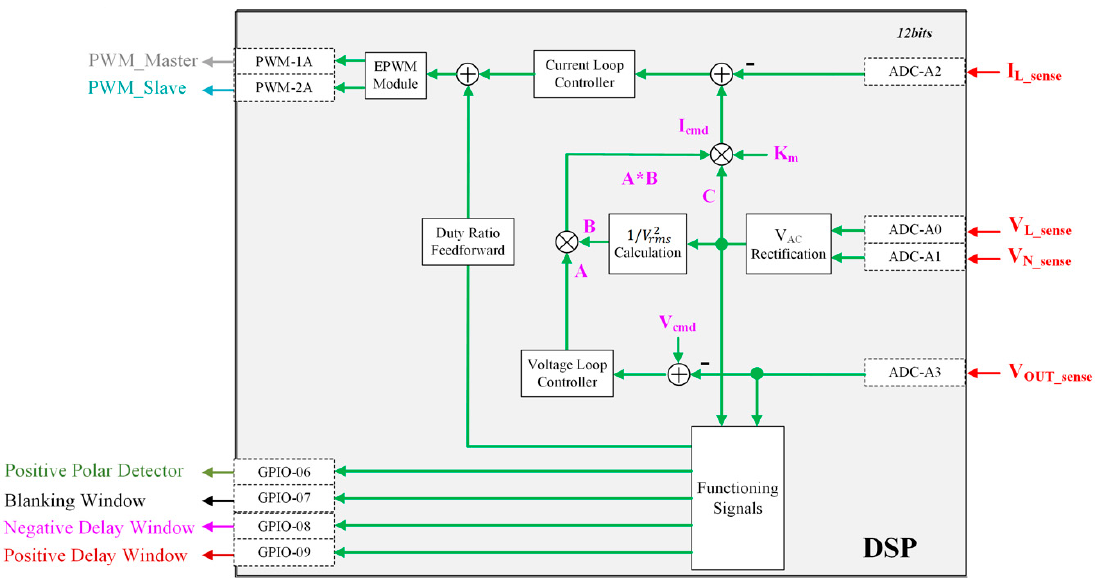
Figure 5. Functional block diagram of the controller within the digital signal processor (DSP).